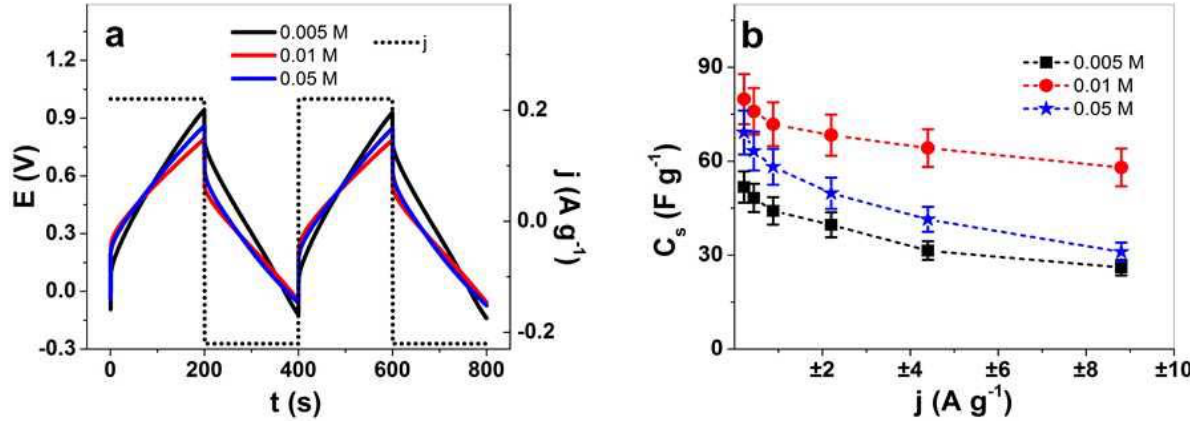
Figure 5. Square potential steps of PPy/DBS-PT films in the TBAPF 6 -PC electrolyte with different PTA concentrations during polymerization, such as 0.005 M (black line, ∎ ), 0.01 M (red line, ● ), and 0.05 M (blue line, ⋆ ), at a frequency of 0.005 Hz in ( a ) strain, ε , and in ( b ) stress, σ , against time, t, at potential range, E (dotted line, 1.0 to −0 .55 V) of two subsequent cycles (3rd and 4th). The strain, ε , is shown in ( c ) and the stress differences,  σ , in ( d ) against the charge density upon oxidation, Q ox . Negative strain as shown in ( c ) refers to the main expansion upon reduction and positive strain to expansion upon oxidation. The dashed lines in ( c ) represent the linear fit and are shown for orientation